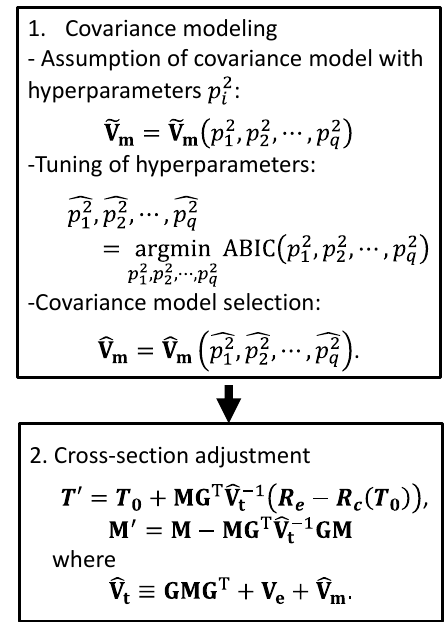
Fig. 2. The procedure of cross-section adjustment using